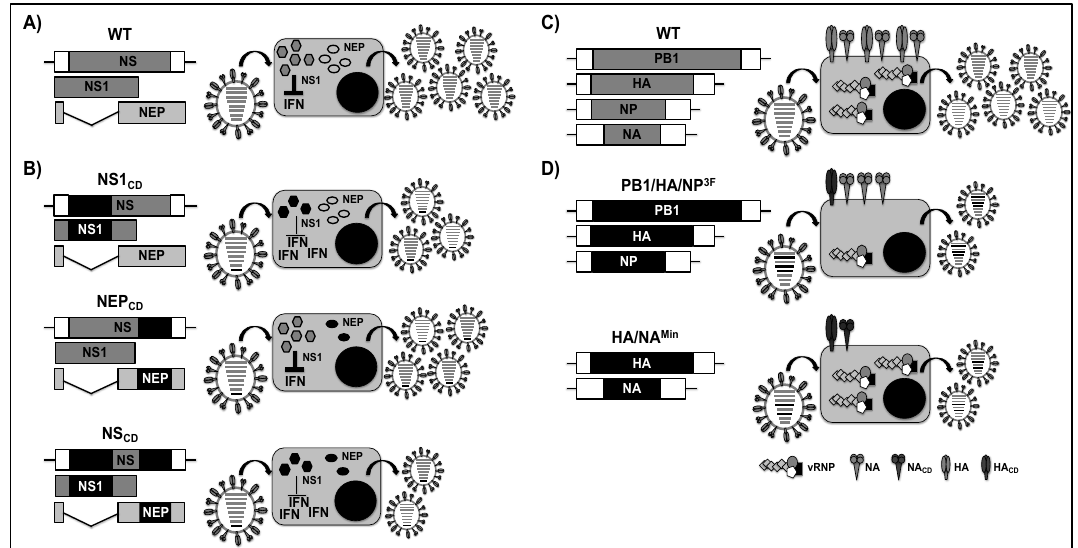
Figure 6. Codon deoptimization (CD) for the generation of LAIV: ( A , B ) Schematic representation of WT ( A ) and CD ( B ) viral NS segments: WT NS vRNA is represented in gray boxes ( A ). WT NS1 and NEP ORFs are represented as dark and light gray boxes, respectively ( A ). CD NS1 (NS1 CD , top), NEP (NEP CD , middle) or both NS1 and NEP (NS CD , bottom) proteins as well as their respective NS vRNA segments are indicated with black boxes ( B ). After infection with a virus encoding a WT NS segment, expression of NS1 results in inhibition of IFN induction, allowing the efficient viral replication ( A ). Infection with viruses encoding a codon deoptimized NS1 protein (NS1 CD , top; NS CD , bottom) results in reduced NS1 protein expression levels and inefficient inhibition of type I IFN responses, resulting in reduced viral replication and viral production. CD of NEP (NEP CD , middle) results in lower expression of NEP, without significantly affecting viral replication. CD of NS1 and NEP (NS CD, bottom) results in higher attenuation than viruses containing only NS1 or NEP CD ORFs, correlating with the amount of codon changes introduced in the viral segment. ( C , D ) Schematic representation of WT and IAV attenuated by codon-pair bias: WT PB1, HA, NP, and NA vRNA segments are indicated in gray boxes ( C ). Codon-pair deoptimized PB1, HA, and NP (PB1/HA/NP 3F ) ( D , top); or, HA and NA (HA/NA Min ) ( D , bottom) proteins are represented in black boxes. During WT viral infection ( C ), vRNPs mediate viral genome replication and gene transcription, allowing efficient viral protein synthesis and viral production. Likewise, optimal expression of the viral HA and NA results in efficient production of infectious viral progeny. Infection with PB1/HA/NP 3F virus ( D , top), results in reduced levels of viral replication and transcription mediated by lower levels of PB1 and NP expression. The codon-pair deoptimization of HA also affects protein expression levels, contributing to the attenuation of the PB1/HA/NP 3F virus in mice but with reasonable growth in vitro. Likewise, the reduction in the level of expression of the viral HA and NA during infection with the HA/NA Min virus ( D , bottom) results in reduced virion formation and therefore lower infectious viral production. White boxes ( A – D ) indicate the packaging signals that were located at the 3´and 5´ ends of each of the vRNAs. Lines at the end of each vRNA ( A – D ) indicate the 3´and 5´